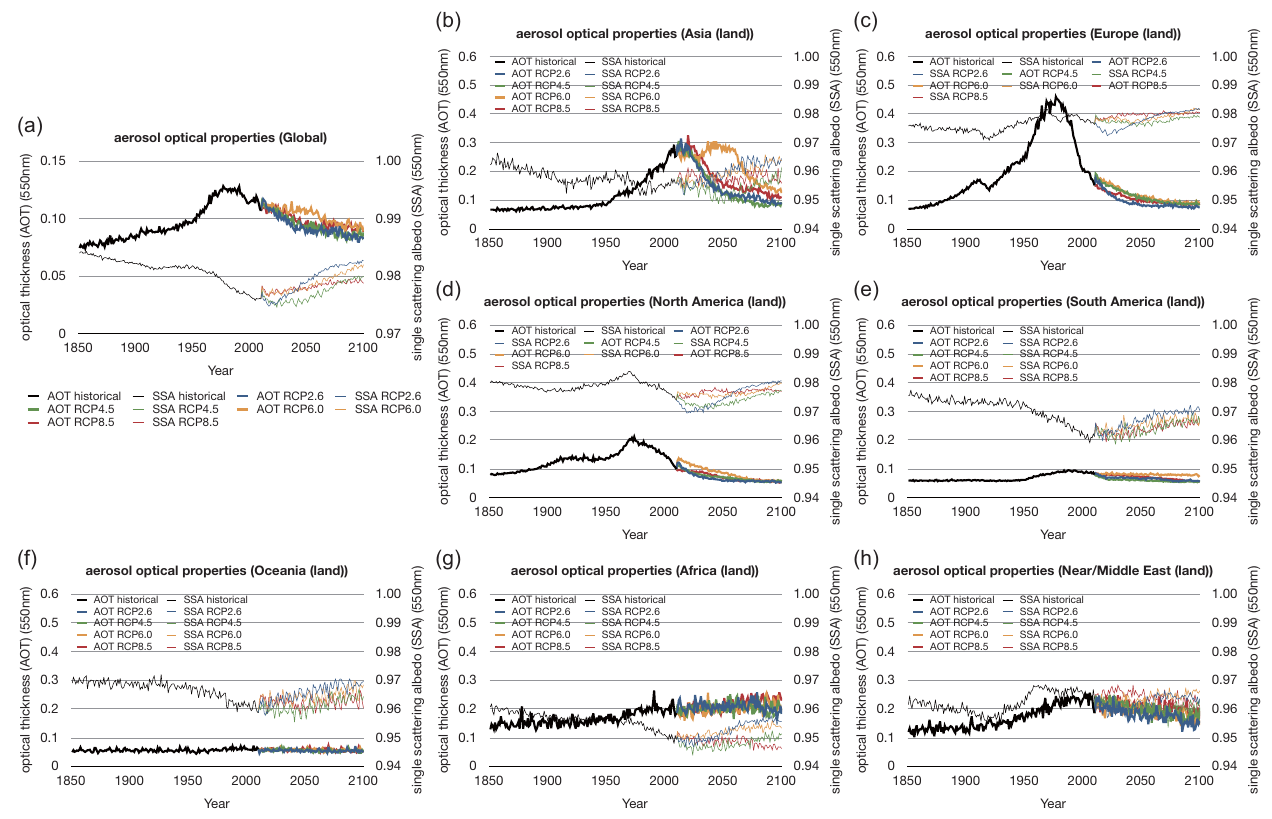
Fig. 6. Time series of annual and (a) global or (b) – (h) regional mean optical thickness (thick lines) and single scattering albedo (thin lines) simulated by SPRINTARS. The regional mean values are only over land. The historical period is shown in black, and the four RCPs are shown in